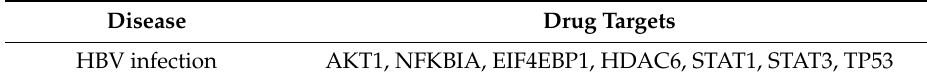
Table 4. The drug targets identified for HBV